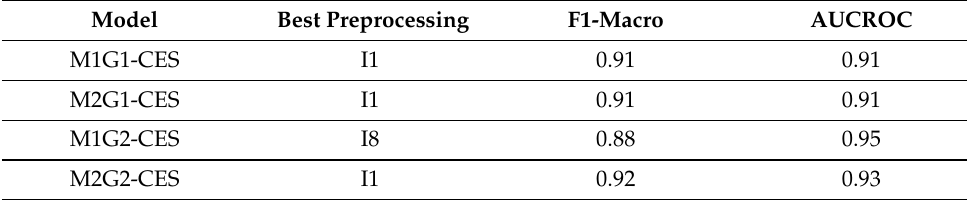
Table 5. Best results for CES predictive models.